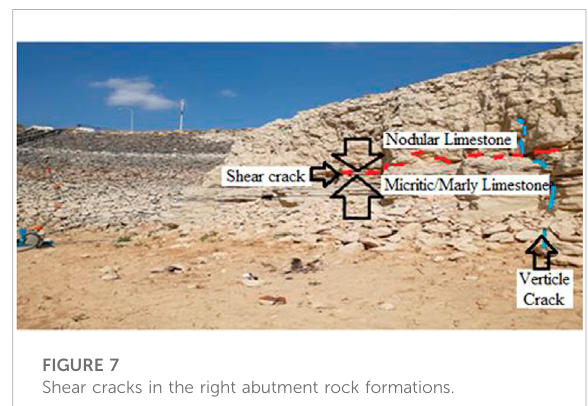
FIGURE 7 Shear cracks in the right abutment rock